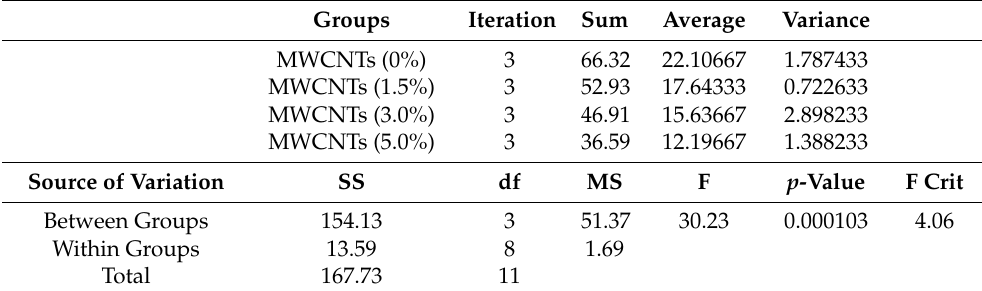
Table 5. Thickness swelling values of MWCNTs-UF MDF for different iterations.